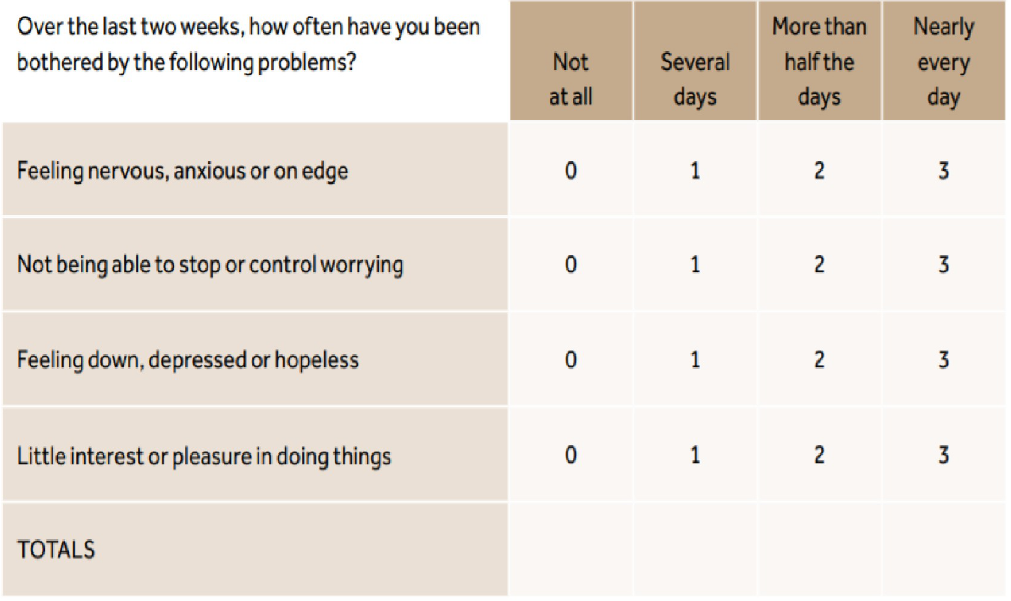
Fig 1. Patient Health Questionnaire-4. Source: Kroenke et al., 2009 [19].